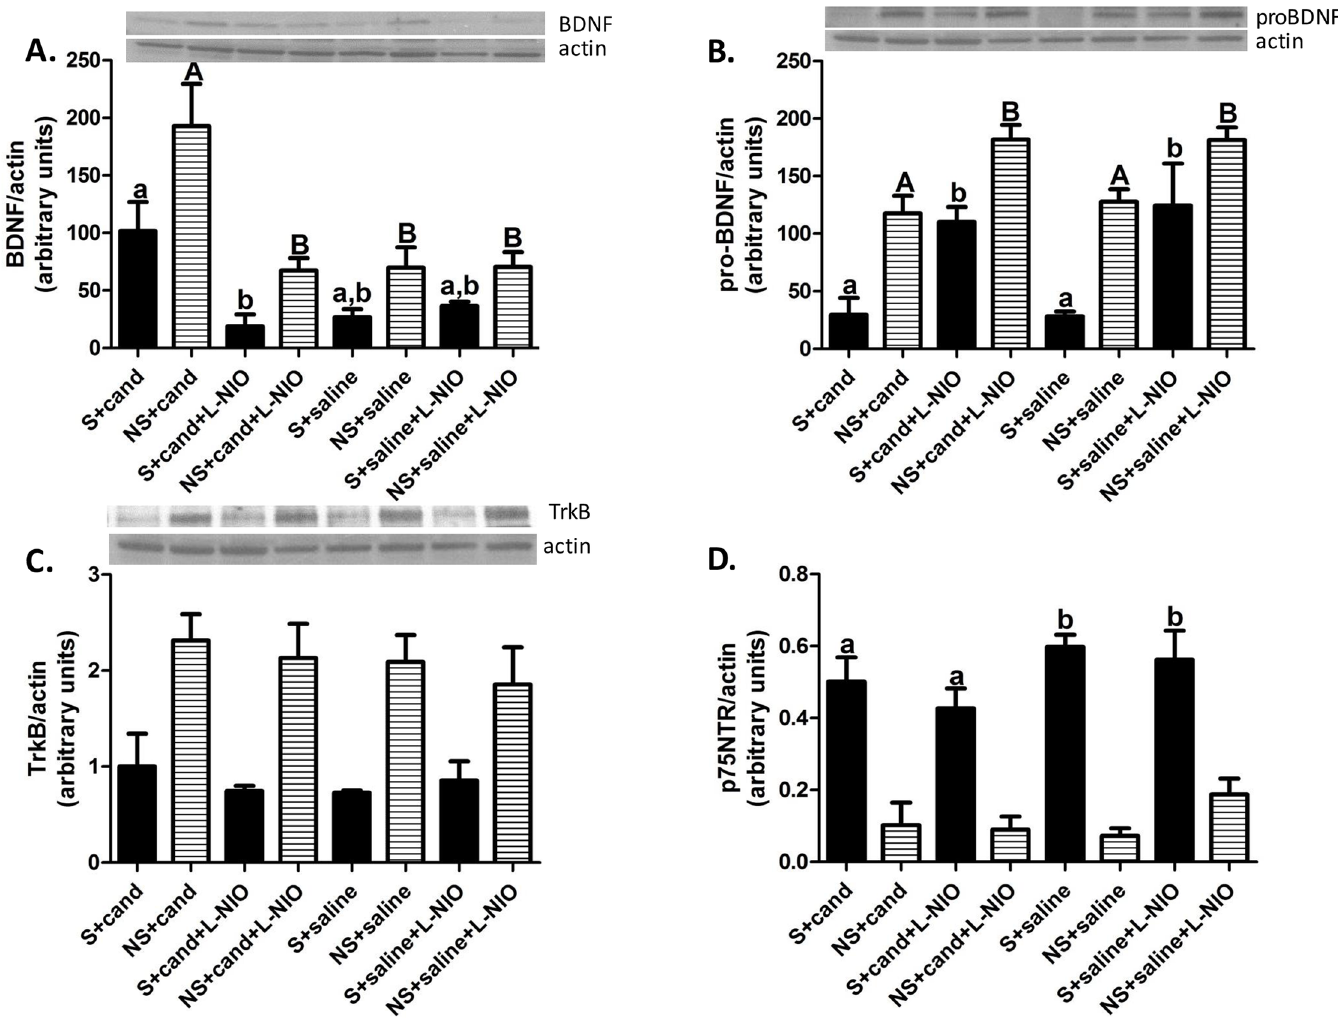
Fig 3. Early AT1 blockade enhanced the prosurvival signaling of BDNF/TrkB in an eNOSdependent manner. Candesartanincreased BDNFexpression inan eNOSdependentmanner(F = 8.96,df = 3; p = 0.035)(A). eNOS inhibitionincreasedproBDNFexpressionin both hemispheres (ipsilateralF = 5.5, df = 3; p = 0.018;contralateral= 7.27,df = 3; p = 0.007)(B). eNOSinhibitionincreased p75NTRin the ipsilateralhemisphere (pvaluefor interaction= 0.038)(D). TrkB expression was not alteredby anyof the usedinterventions (C). Datapresented as mean ± SEM. Solidcolumnsrepresent ipsilateralhemisphere, striped columns represent contralateral hemisphere. S refersto the ipsilateralhemisphere; NS refersto the contralateralhemisphere. a, b or A, B Pairsof meanswith different lettersand/orcapitalizationare significantly differentfrom eachother.n = 4 animalsper group.